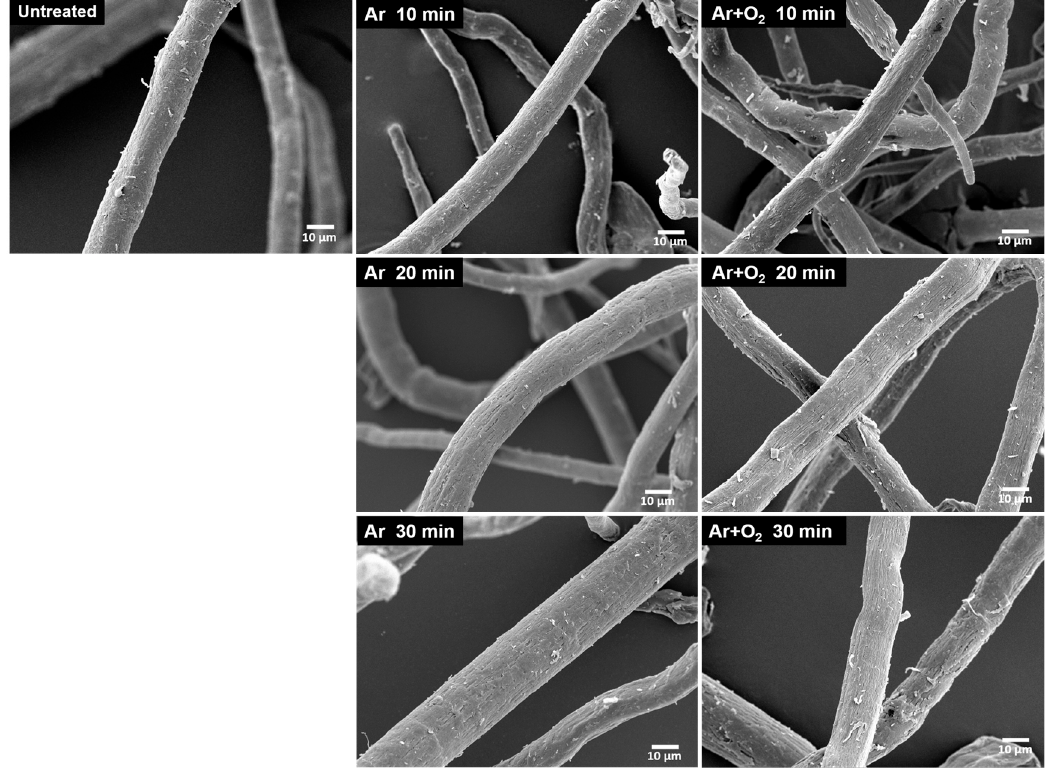
Figure 8. SEM images of the morphology of BFs treated with difference gas plasmas for various treatment times at 1000×.